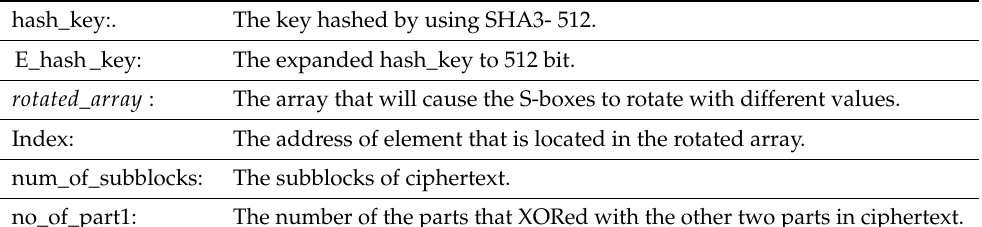
Table 2. List of